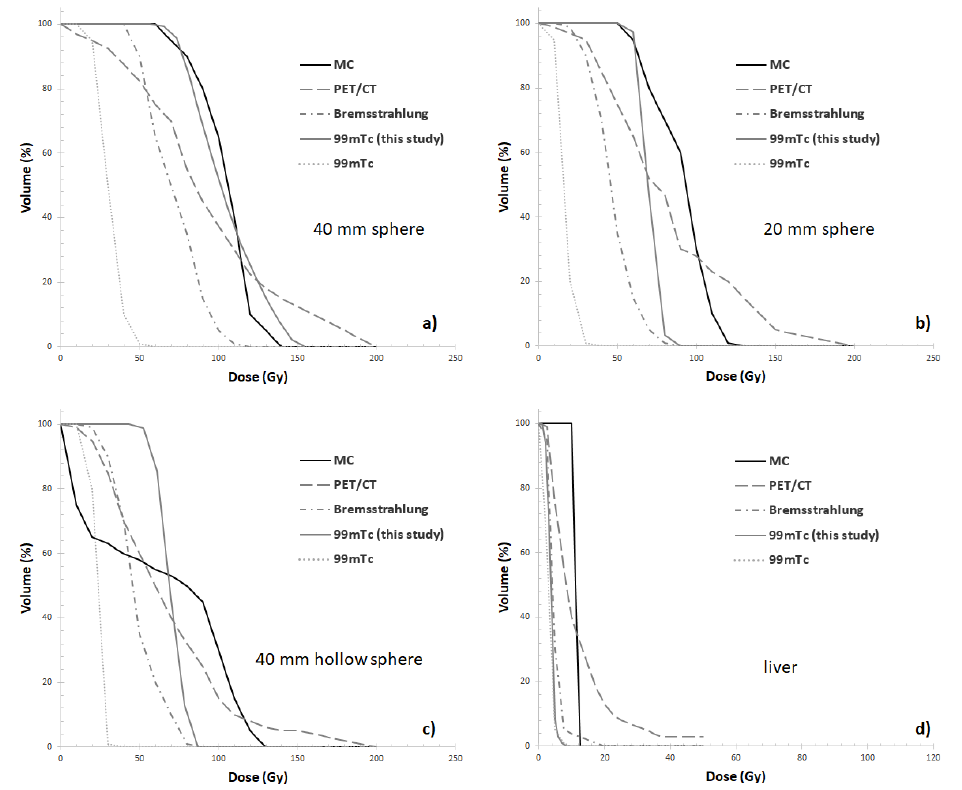
Figure 6. Cumulative DVH comparisons between 99m Tc SPECT/CT of this study and those (rescaled) reported by Gear et al. in [19] for Monte Carlo (MC), 90 Y-PET/CT (PET/CT), 90 Y-SPECT/CT (Bremsstrahlung) and 99m Tc SPECT/CT ( 99m Tc) for the AbdoMan inserts ( a ) 40 mm sphere, ( b ) 20 mm sphere, ( c ) 40 mm hollow sphere with 25 mm solid inner sphere, simulating a neovascular rim around a necrotic core) and ( d ) liver